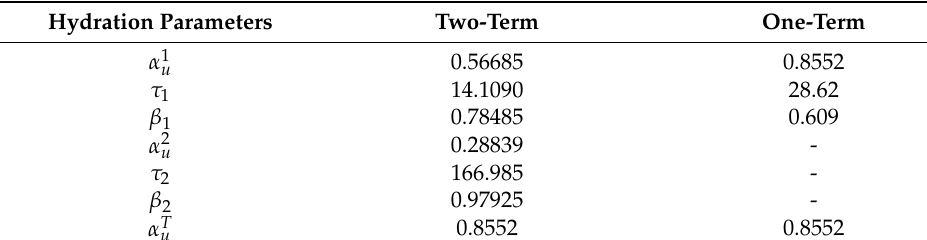
Table 4. Hydration parameters for finite element analysis.